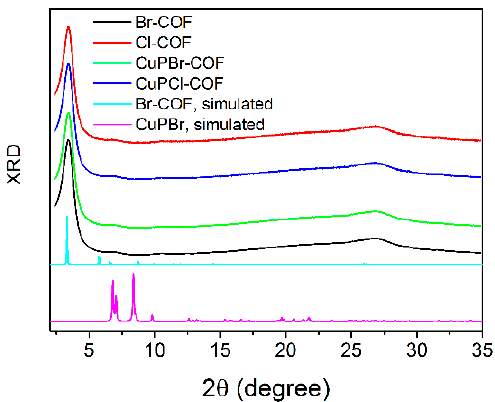
Figure 4. Recorded XRD curves of X-COF, CuPX-COF, along with simulated XRD peak of Br-COF and CuPBr, X = Br and Cl.